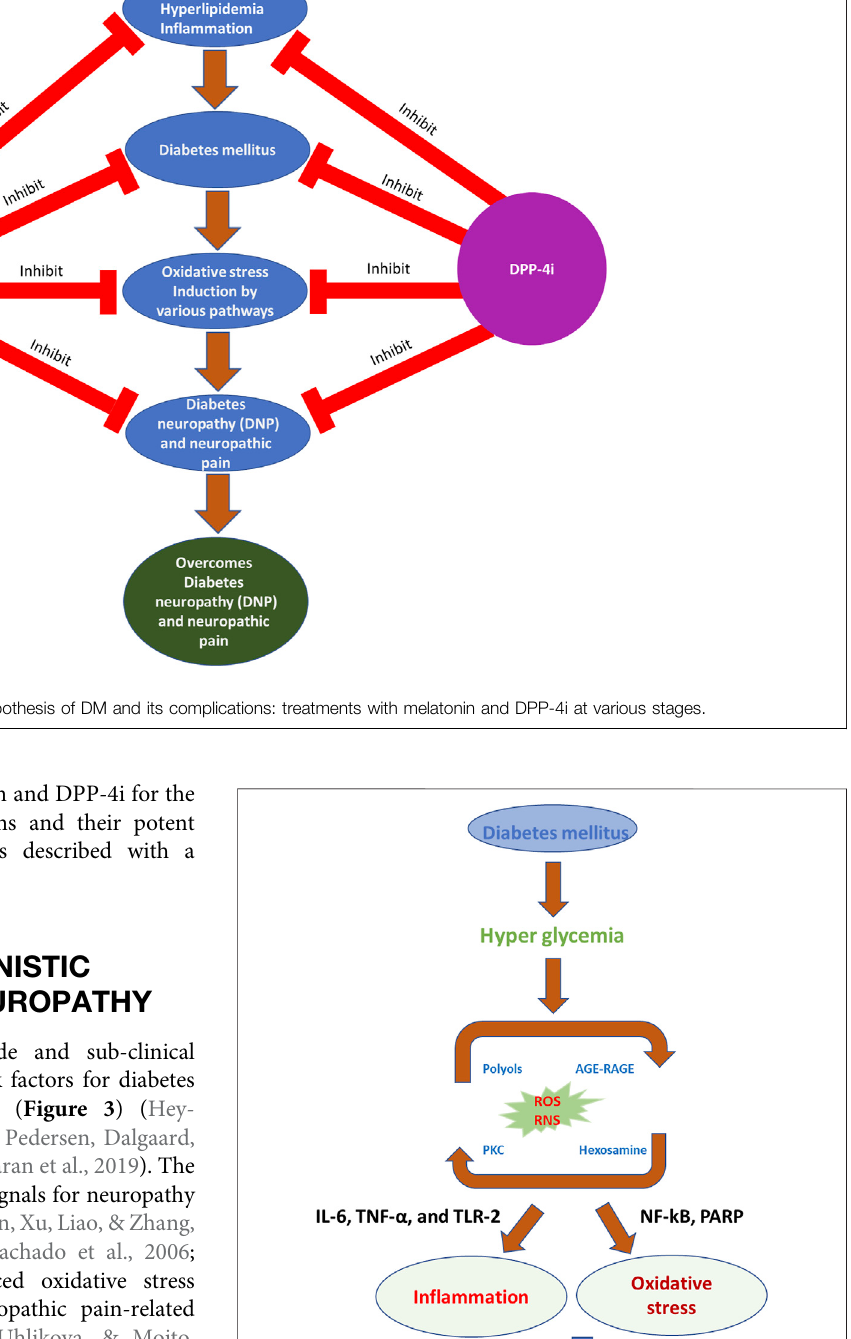
Frontiers in Pharmacology |